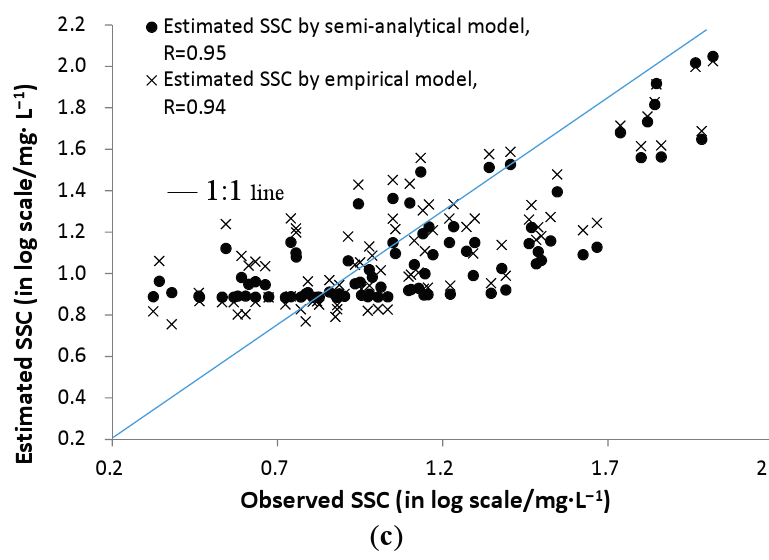
Figure 7. ( a ) The comparison of retrieved SSC levels using semi-analytical model and empirical model. ( b ) The first derivative functions of semi-analytical model and empirical model. ( c ) The relationship between observed SSC and SSC estimated by the two